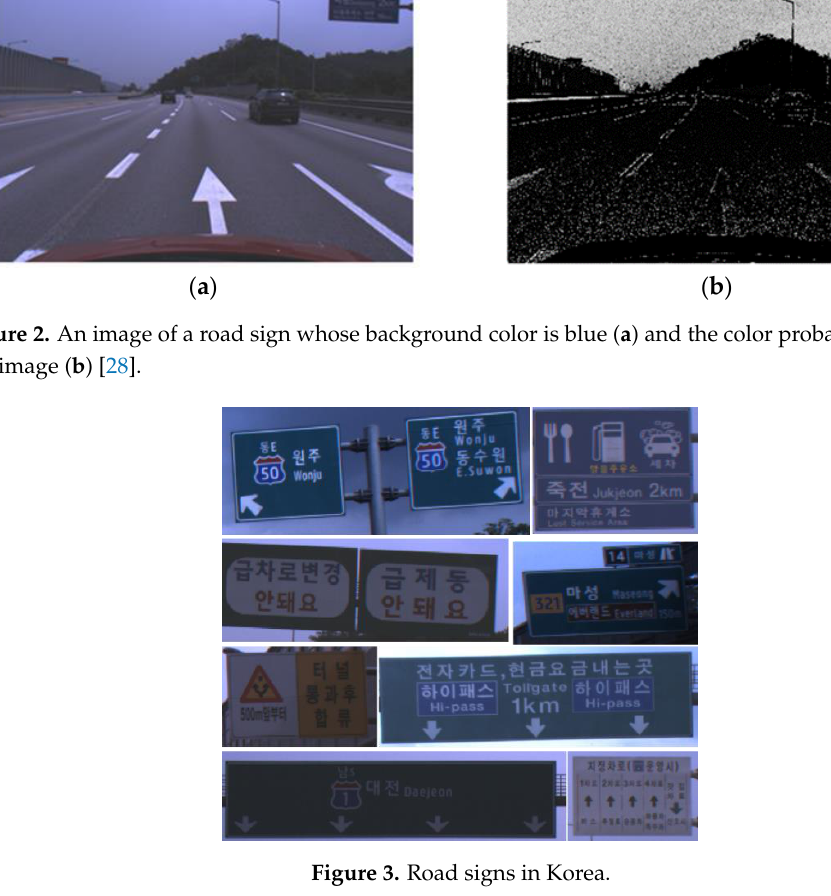
Figure 3. Road signs in Korea.